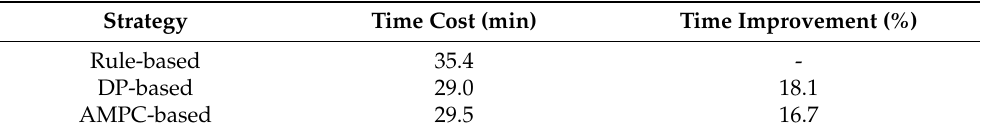
Table 7. Time cost